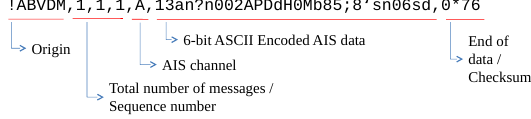
Figure 5. NMEA sentence containing AIS position report